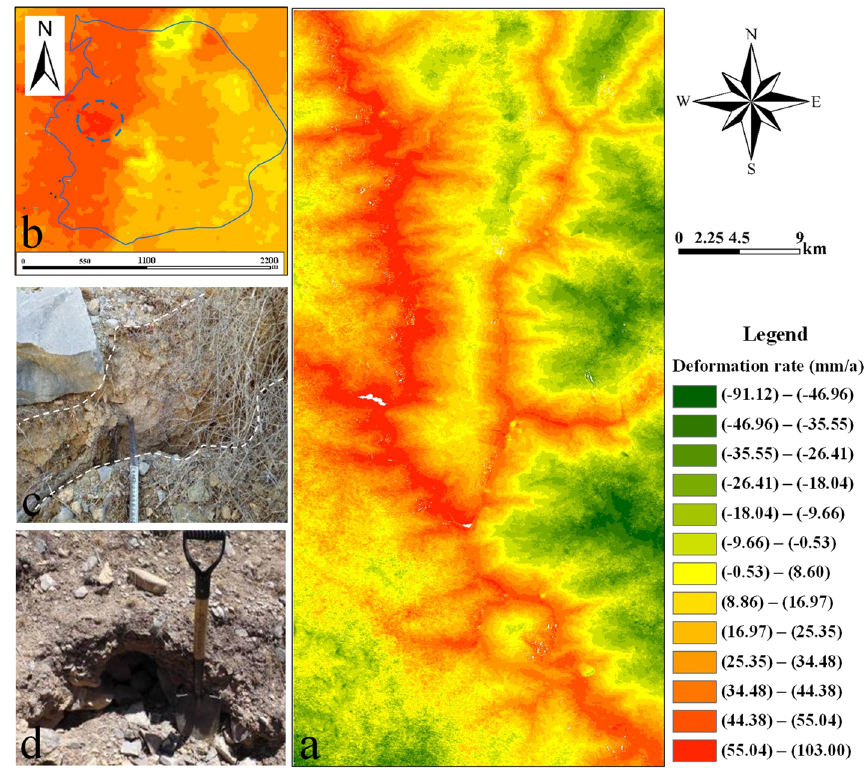
Figure 4. ( a ) InSAR interpretation results of the study area, and ( b – d ) InSAR interpretation results of the Taentong landslide and its internal tensile cracks.